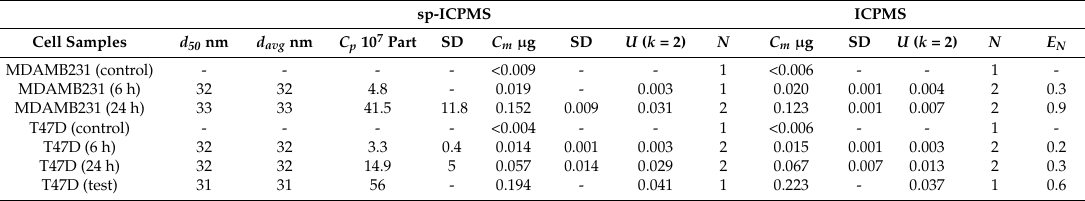
Table 3. Sp-ICPMS and ICPMS analysis of the tumor cell samples: d 50 and d avg are the median and average diameters, respectively; C m is gold mass per pellet; SD is the standard deviation; U is the expanded uncertainty on the gold masses; C p is the particle number per pellet. E N numbers were calculated for the gold masses between the ICPMS and the sp-ICPMS measurements of the same samples. N is the number of independent dilutions analyzed.